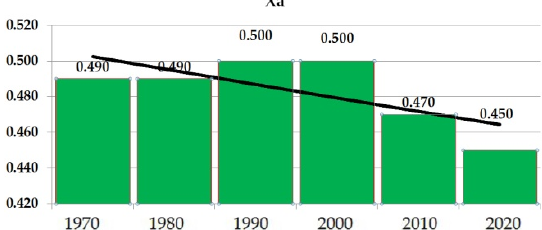
Figure 13. River basin planning, coefficient of the river basin planning, xa.